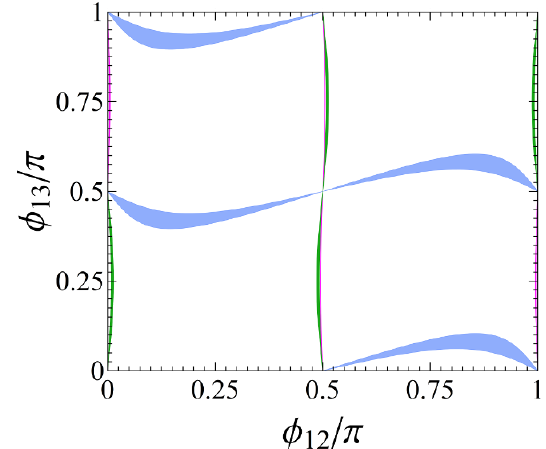
Figure 9 . Predictions for the Majorana CP violation phases (cid:30) 12 and (cid:30) 13 as a function of the CP label (cid:2). The light blue, magenta and green regions are for the generalized e (cid:0) (cid:22) , e (cid:0) (cid:28) and (cid:22) (cid:0) (cid:28) symmetries, respectively. Here we choose (cid:11) = (cid:12) = (cid:13) = 0.